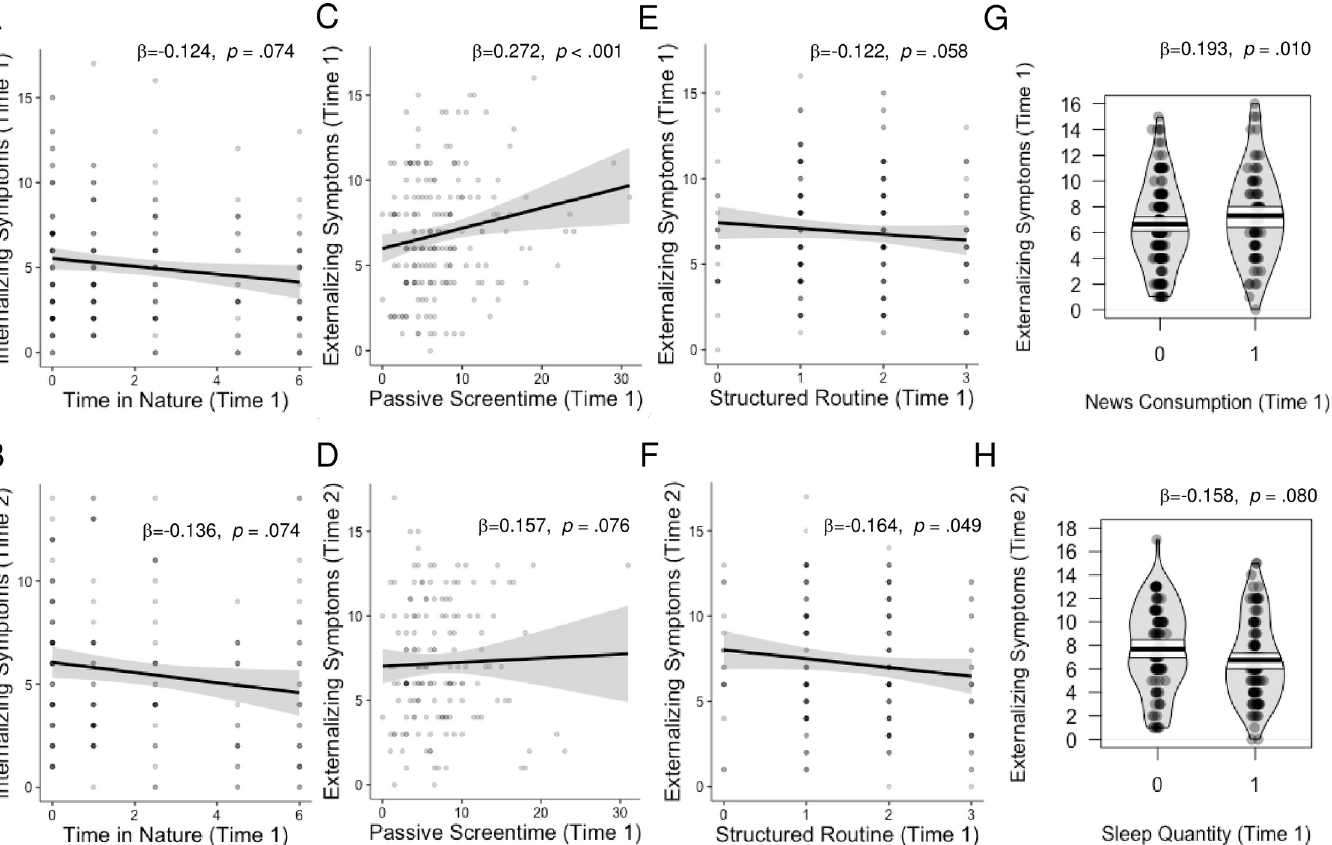
Fig 2. Main effects of protective factors on psychopathology. All analyses controlled for age, sex, income-to-needs, and pre-pandemic psychopathology symptoms.